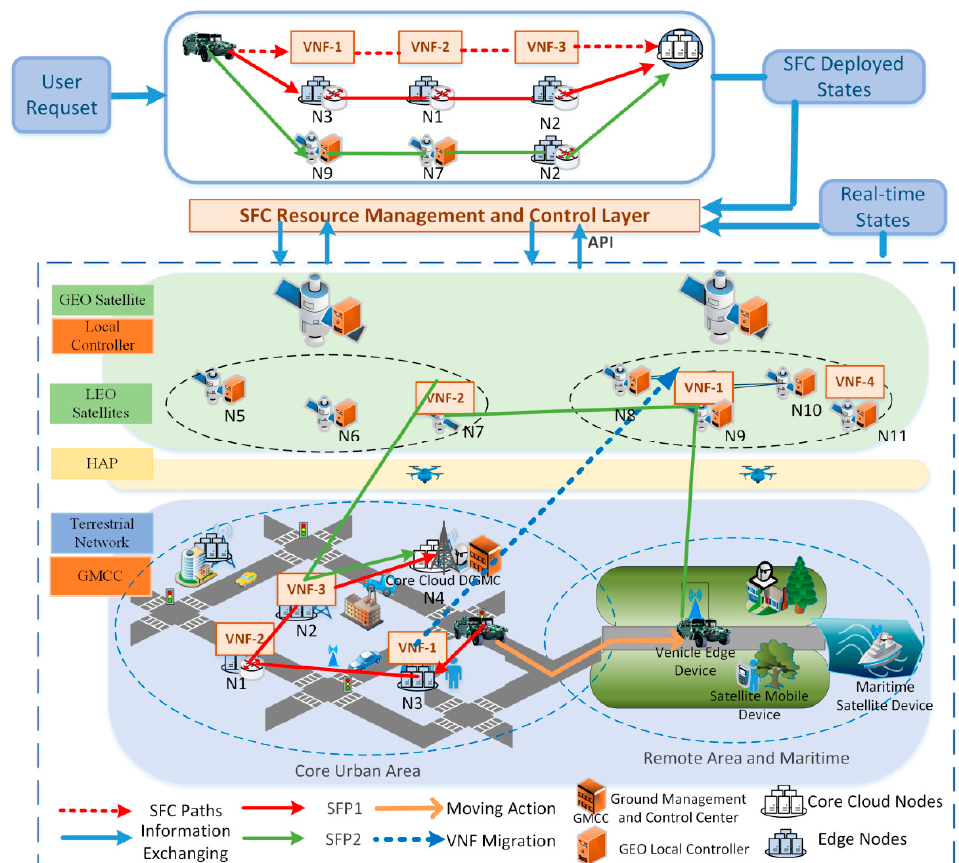
Figure 1. Service migration and reconfiguration process in satellite–terrestrial integration networks.